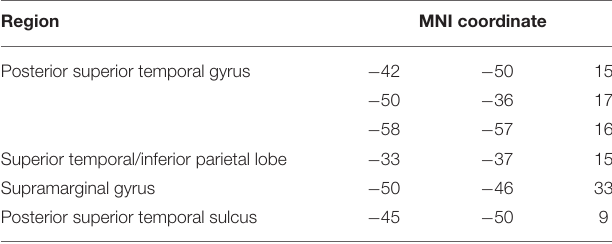
TABLE 6 | Peak VLSM results, threshold ≤